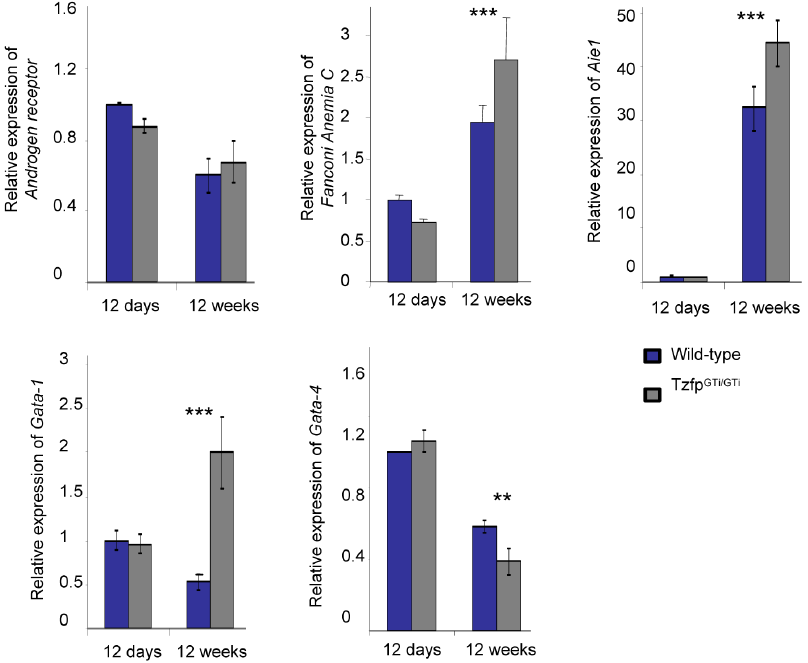
Figure 3. Gene expression analysis. RT-PCR results showing gene expression in wild-type and Tzfp GTi/GTi testis at age 12 days and 12 weeks. Transcripts analyzed are Androgen Receptor , Fanconi anemiaC , Aie1 , Gata-1 and Gata-4 . Statistical analysis was performed by using the two-tailed Student’s t test: *p , 0.05; **p , 0.01; ***p , 0.001.